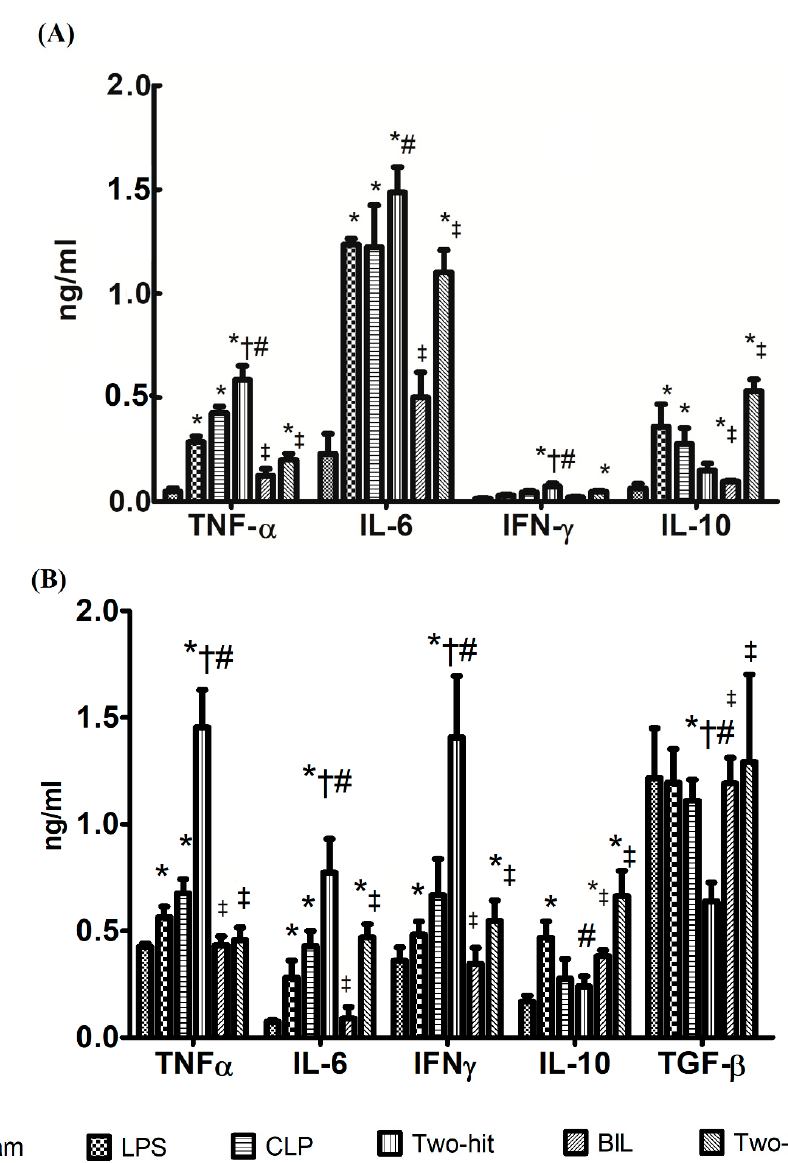
Figure 2. Bilirubin effects on the expression of pro- and anti-inflammatory cytokines in the ( A ) plasma; ( B ) lung of the “two-hit” sepsis model. Mice were administered i.p. LPS at 5 mg/kg body weight on day 0. After 24 h, the mice were challenged with cecal ligation and puncture (CLP: 25-gauge needle and double-puncture). Next, the mice were administered bilirubin at 30 mg/kg body weight. The levels of pro-inflammatory (TNF- α , IL-6, IFN- γ ) and anti-inflammatory cytokines (IL-10 and TGF- β ) were determined by ELISA after one day. Data are shown as mean ± SD (n = 5 mice per group) and analyzed by one-way ANOVA with Tukey–Krammer multiple comparison test using the SPSS program. * p < 0.05 versus sham. # p < 0.05 versus LPS. † p < 0.05 versus CLP. ‡ p < 0.05 versus “two-hit”. Tumor necrosis factor-alpha (TNF- α ), interleukin (IL)-6, and interferon-gamma (IFN- γ ), interleukin IL-10 and transforming growth factor- β (TGF- β ). LPS: lipopolysaccharide, CLP: cecal ligation and puncture, BIL: